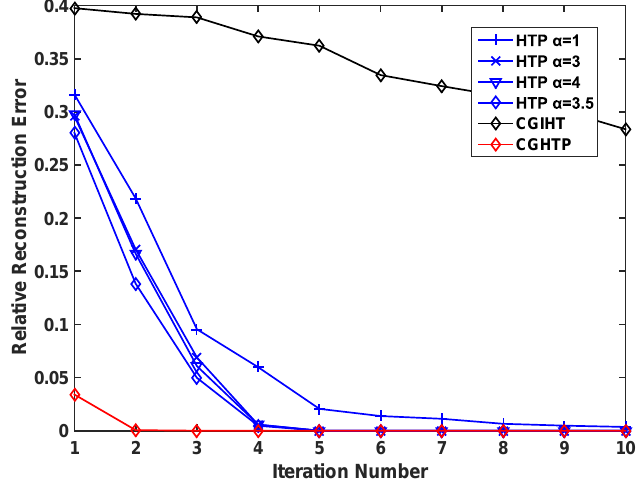
Figure 7. Relative reconstruction error vs. iteration number, ( s = 20, M =